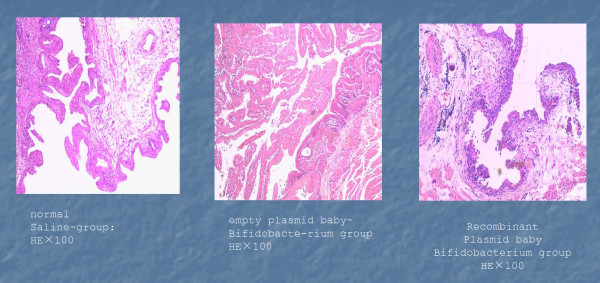
Histologic evaluation of the MNU-induced rat bladder cancer. MNU-induced bladder tumor samples were retrieved and subjected to paraffin-embedded sectioning and H & E staining. (A) Normal saline group, (B) Bifutobacterium infantis with empty plasmid group, and (C) Bifutobacterium infantis-PGEX-TK group. Representative samples are shown. Magnification, 100×.